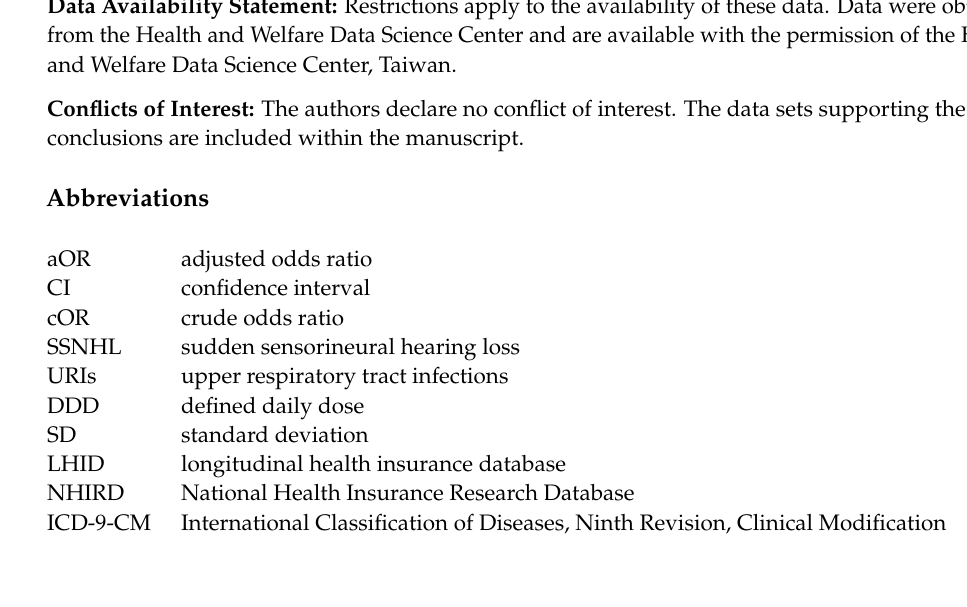
Table S1: Subgroup analysis of different age groups for acute URIs and SSNHL risk in different exposure